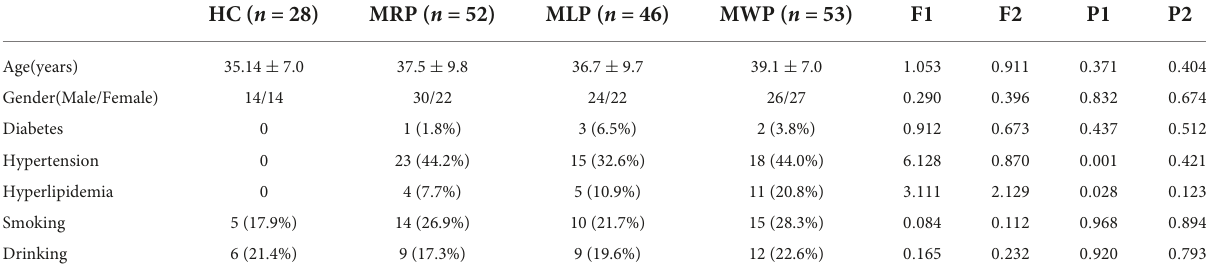
TABLE 1 Demographic data of the study subjects.